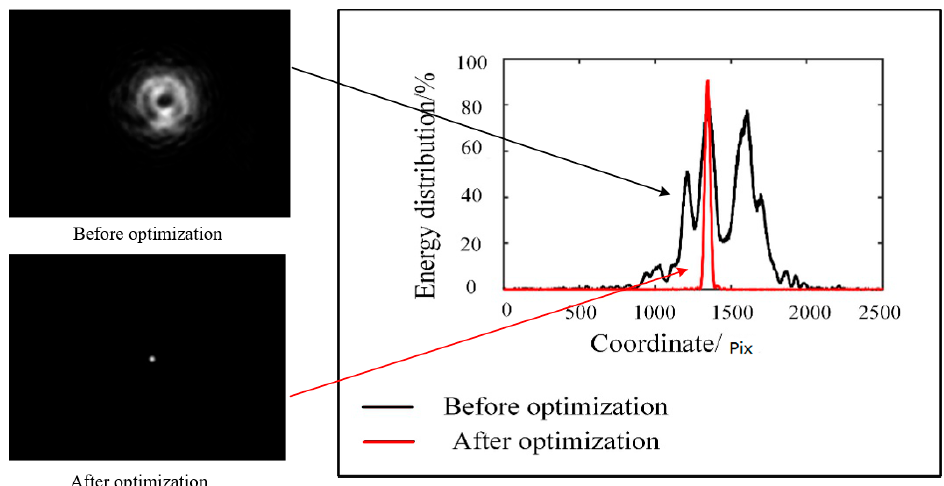
Figure 6. Comparison of imaging spots before and after optimization.